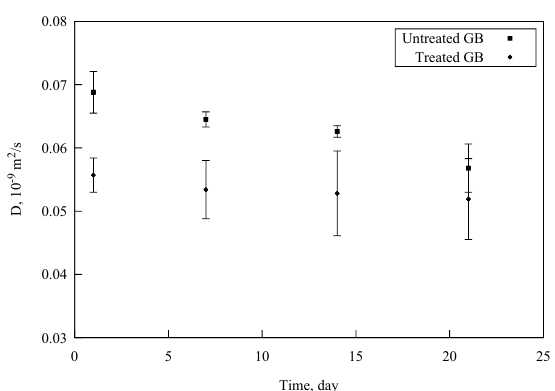
Figure 6. Diffusion coefficient behavior of treated and untreated glass beads with oil at different aging times at 25 ◦